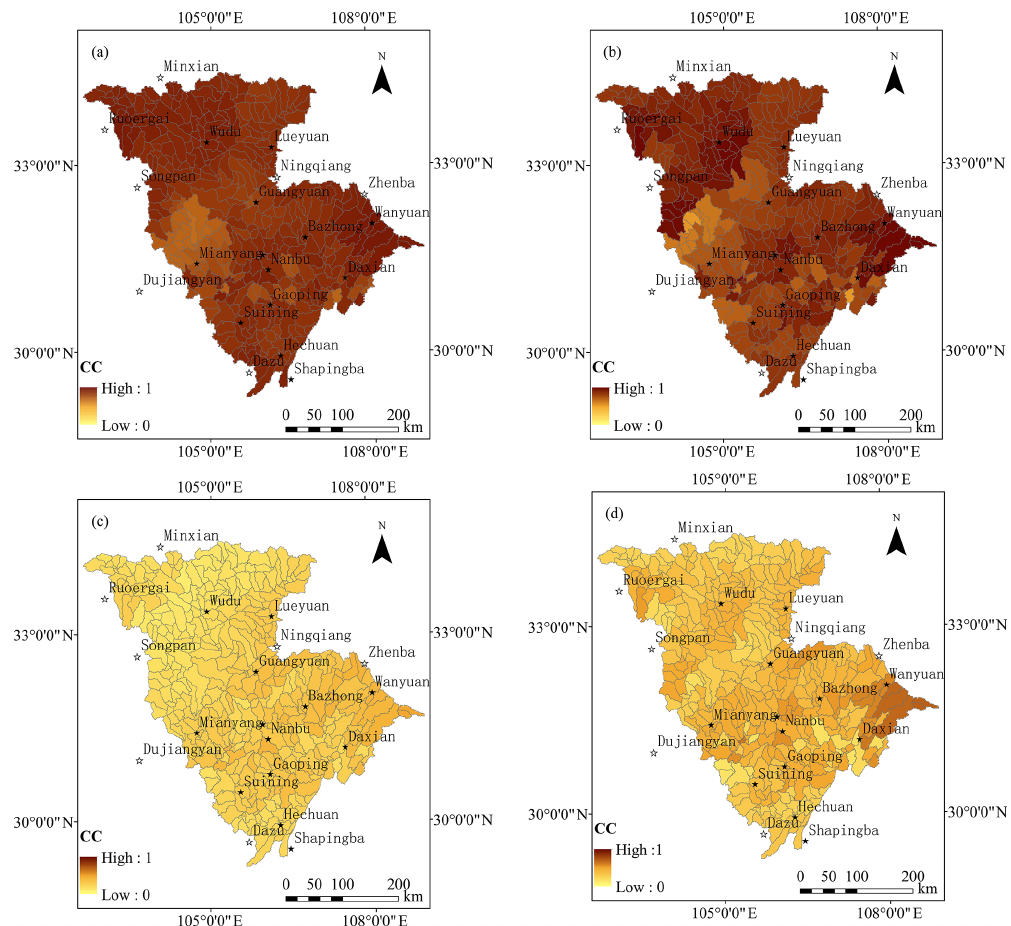
Figure 8. Spatial variation of CC values of the precipitation between (a) Gauge and CHIRPS and (b) Gauge and CPC at a monthly scale and (c) Gauge and CHIRPS and (d) Gauge and CPC at a daily